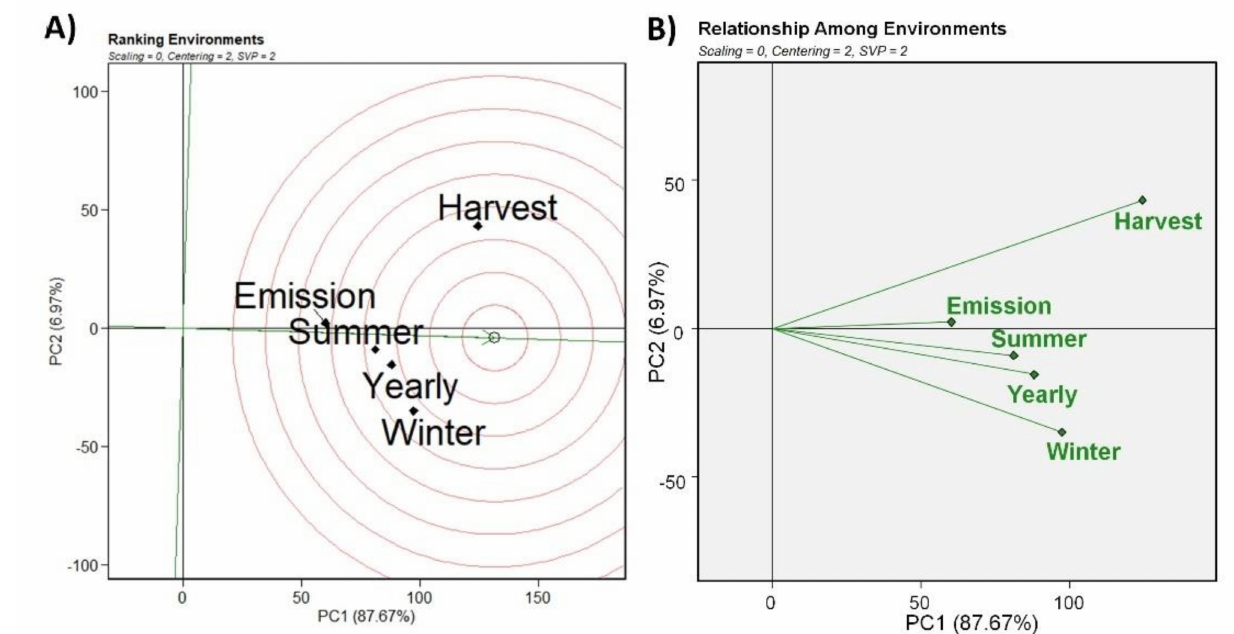
Figure 3. Classification of different selection criteria (environments) based on their performance close to the ideal method of selection of banana genotypes for resistance against Pseudocercospora fijiensis ( A ) and the relationship between the selection criteria of banana genotypes resistant to Pseudocercospora fijiensis ( B ). The data were generated from the values of the internal index of the